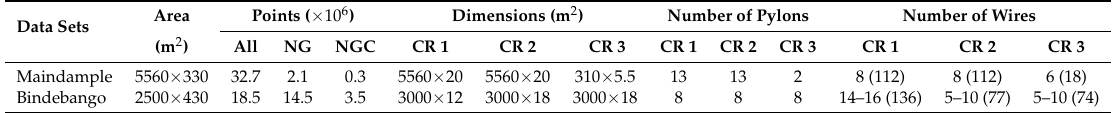
Figure 14. The test datasets: ( a ) Maindample, Victoria; and ( b ) Bindebango, Queensland. In the three samples, only the non-ground points with at least 1 m height above the ground are shown. Samples 2 and 3 are used in Figures 2 and 12, respectively. Table 2. Summary of the two Australian test datasets (NG, non-ground points; NGC, non-ground points within corridor; and CR,